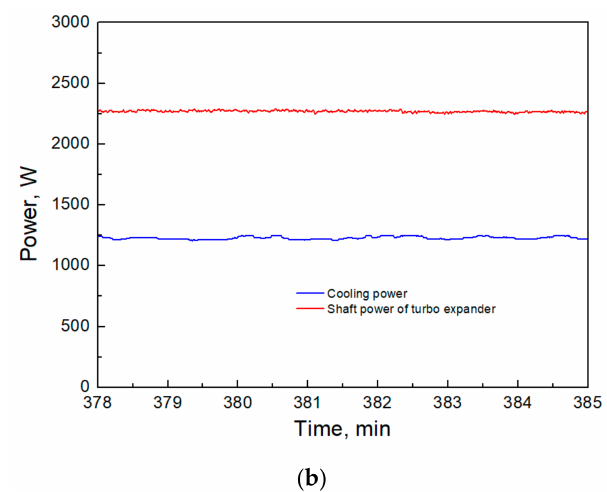
Figure 8. Measurement results of the proposed system: ( a ) T-s diagram comparison and ( b )